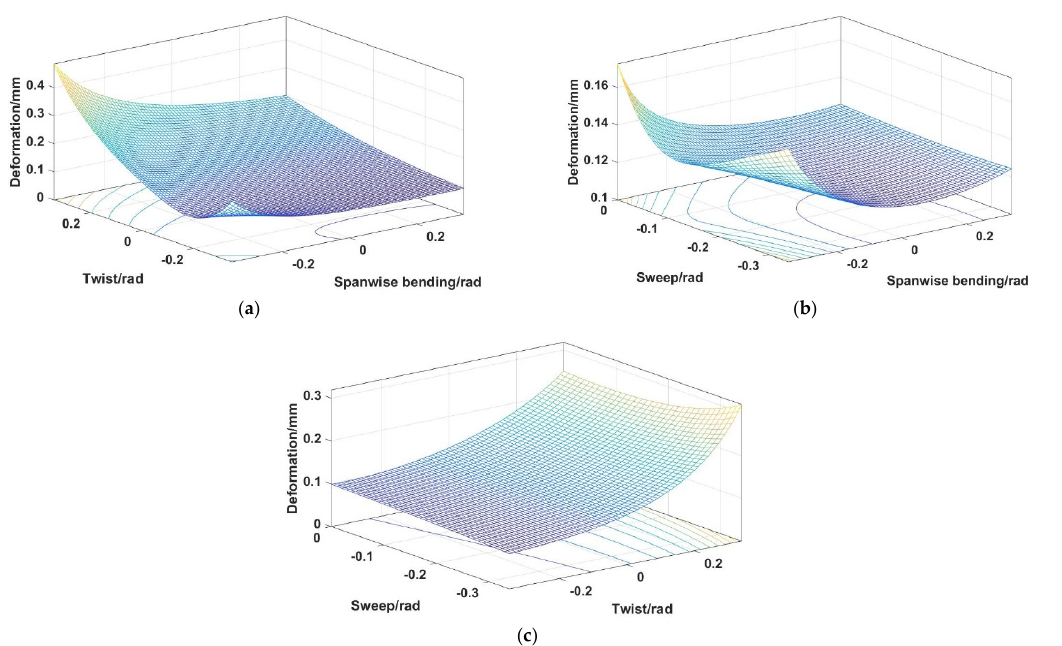
Figure 17. The relationship between the deformation of the 4SPS-RS parallel mechanism and sweep, twist, spanwise bending at the minimum span: ( a ) the relationship between the deformation and twist, spanwise bending; ( b ) the relationship between the deformation and sweep, spanwise bend- ing; ( c ) the relationship between the deformation and sweep, twist.